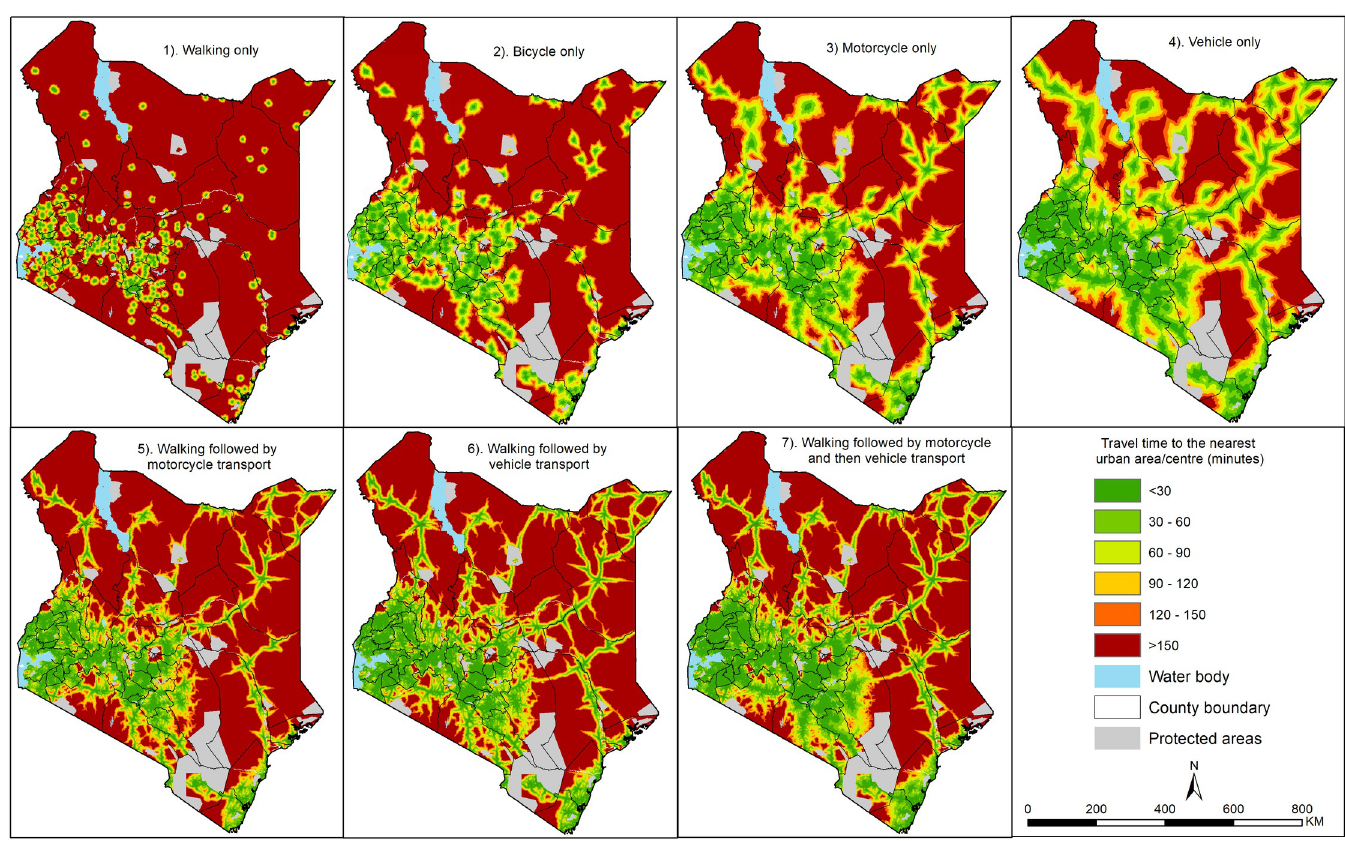
Fig 4. Travel time (spatial accessibility) to the nearest urban area for seven travel scenarios classified into bins of thirty minutes highlighting areas with better access (green) to the most marginalised (brown). Walking only (scenario 1), bicycle only (scenario 2), motorcycle only (scenario 3), vehicle only (scenario 4), walking followed by motorcycle transport (scenario 5), walking followed by vehicle transport (scenario 6), and walking followed by motorcycle and then vehicle transport (scenario 7). Source: authors.